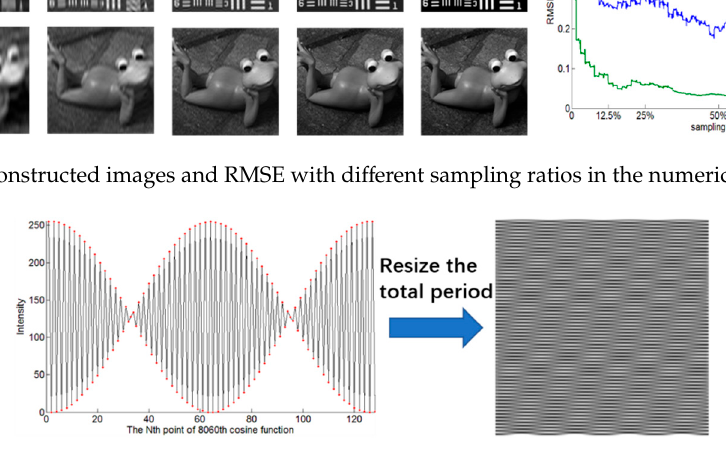
Figure 4. Insufficient sampling capacity of the Fourier matrix in high frequencies. Figure 4. Insu ffi cient sampling capacity of the Fourier matrix in high